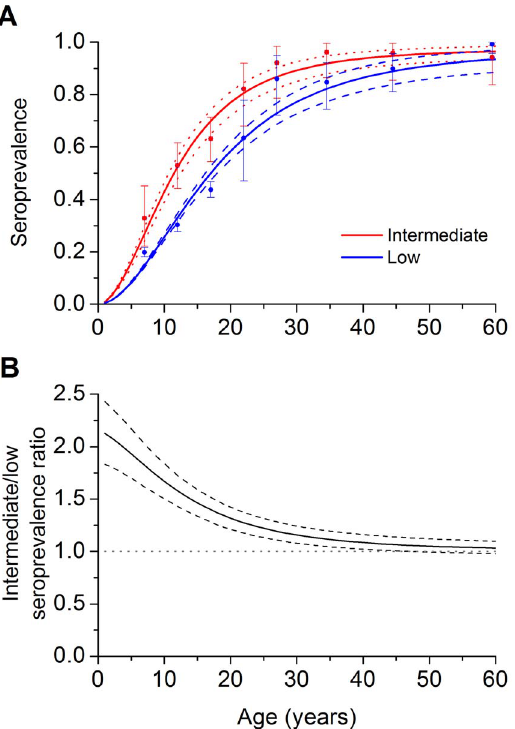
Figure 2. Seroprevalence fitted curves of HA infection (solid lines) for the intermediate ( x 2 =6.7, p =0.349) and low endemicity ( x 2 =85.5, p , 0.001) areas (A), the corresponding 99% CIs (red dotted and blue dashed lines, respectively), and 95% confidence intervals for the observed data (error bars); (B) Seroprevalence ratio of HA infection between the intermediate and low endemicity areas by age (solid line) and its corre- sponding 99% CI (dashed lines). A value of 1 denotes an equal prevalence in both areas, an integer . 1 indicates a higher prevalence in the intermediate endemicity area, and a value , 1 indicates a higher prevalence in the low endemicity area. The fitting parameters were: k 1 ~ (0 : 01762 + 0 : 00096) year 2 2 and k 1 ~ (0 : 0699 + 0 : 0048) year 2 1 for the intermediate endemicity area and k 1 ~ (0 : 00815 + 0 : 00018) year 2 2 and k 1 ~ (0 : 0485 + 0 : 0031) year 2 1 for the low endemicity area.